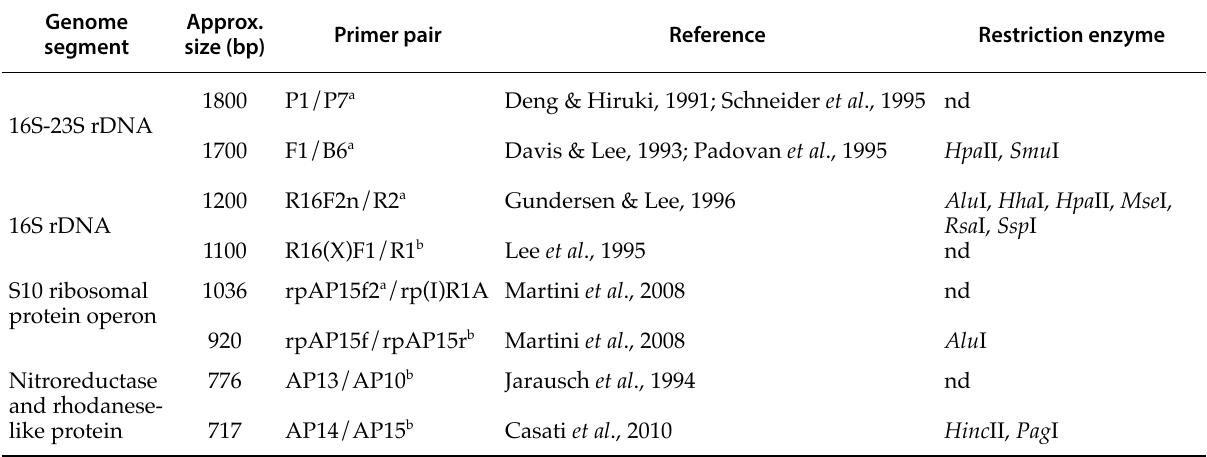
Table 1. Primer pairs and restriction enzymes used in PCR-RFLP analyses of ‘ Candidatus Phytoplasma mali’ strains from a survey of apple trees in Central and Southern Poland during